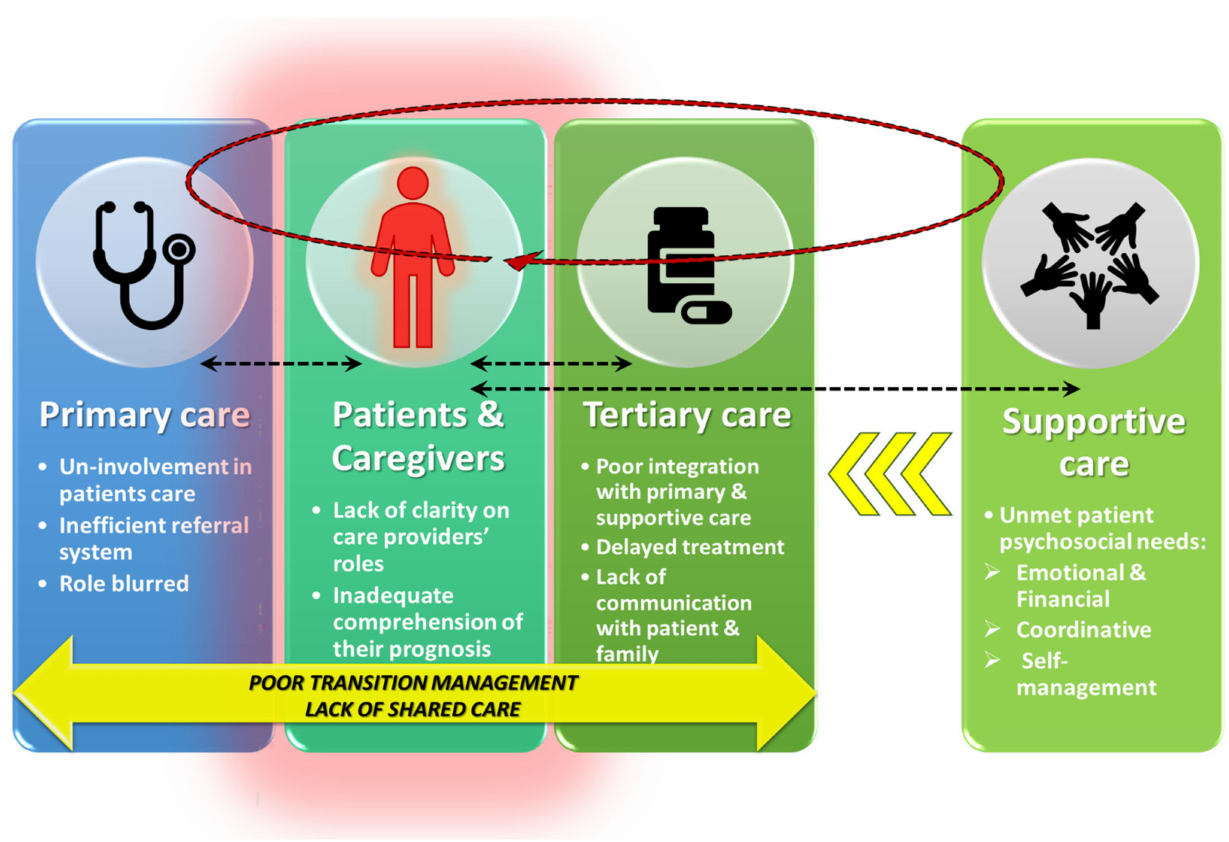
Figure 1. Summary of the key findings derived from this